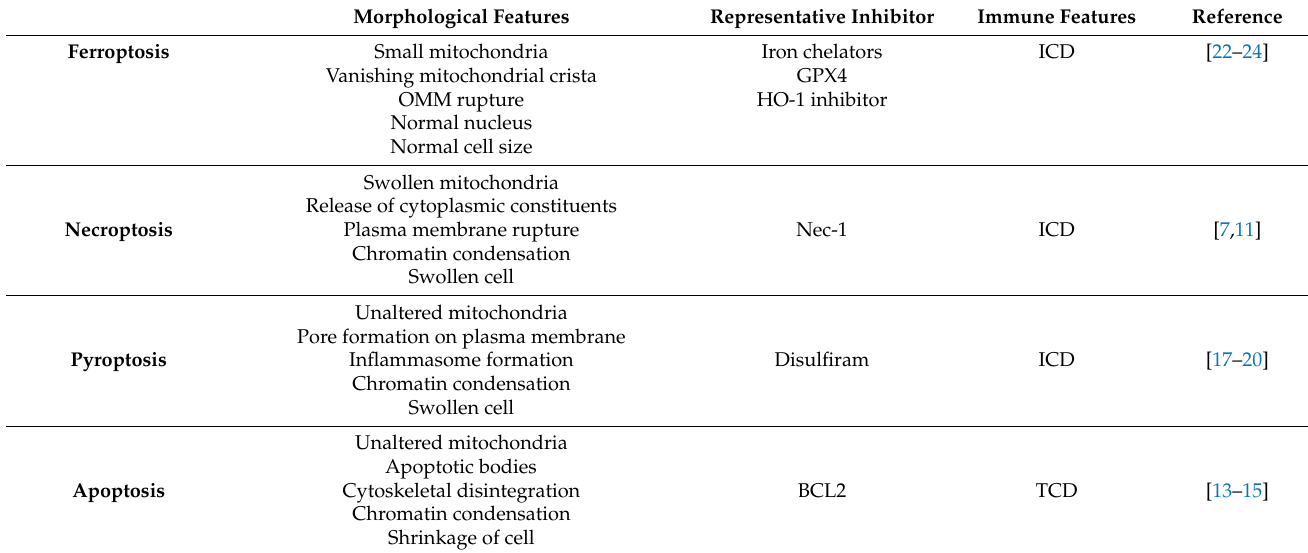
Table 1. Morphological and immune features of ferroptosis, apoptosis, necroptosis, and pyroptosis. Morphological